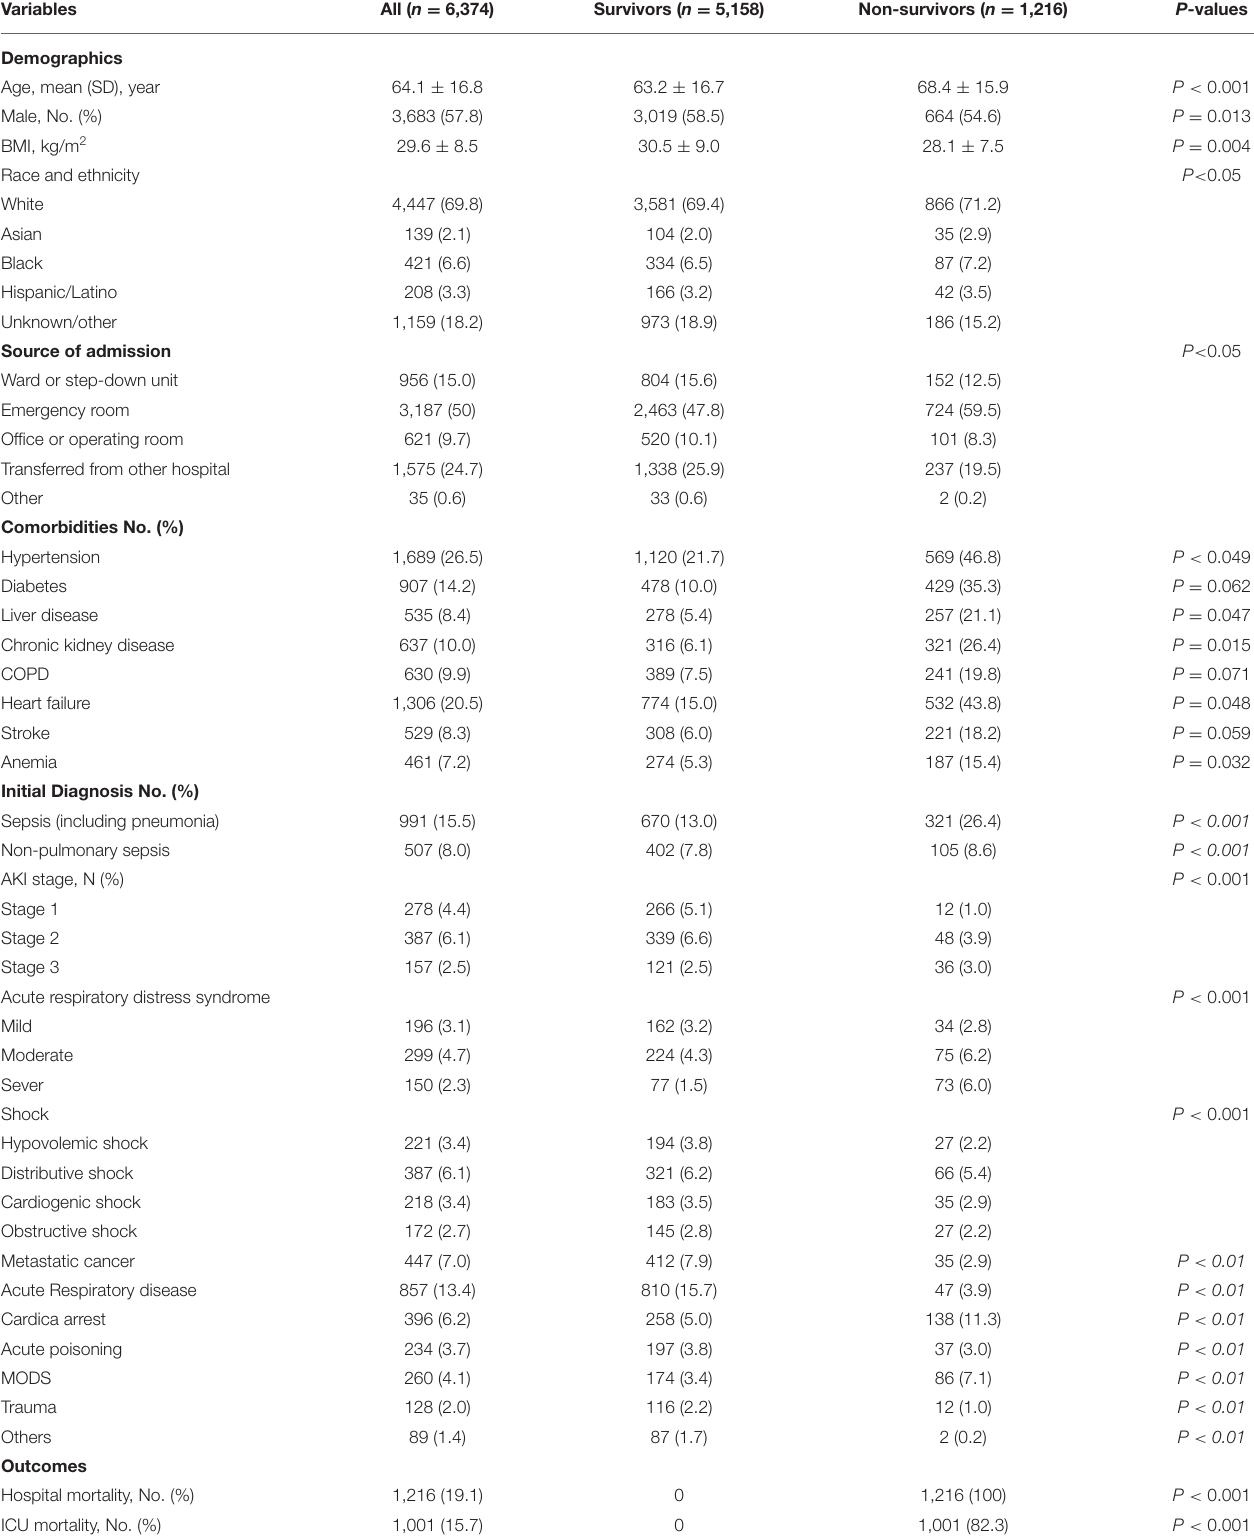
TABLE 1 | Demographics, APACHE II score, outcomes and diagnosis of patient.